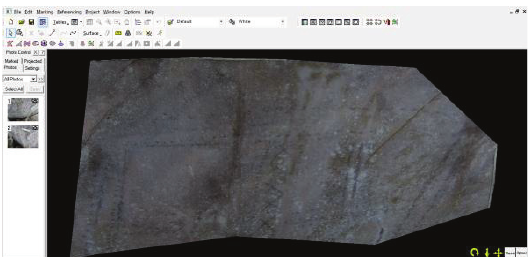
Figure 6: The processing of the terrestrial-based close- range photogrammetric data using PhotoModeler Scanner software